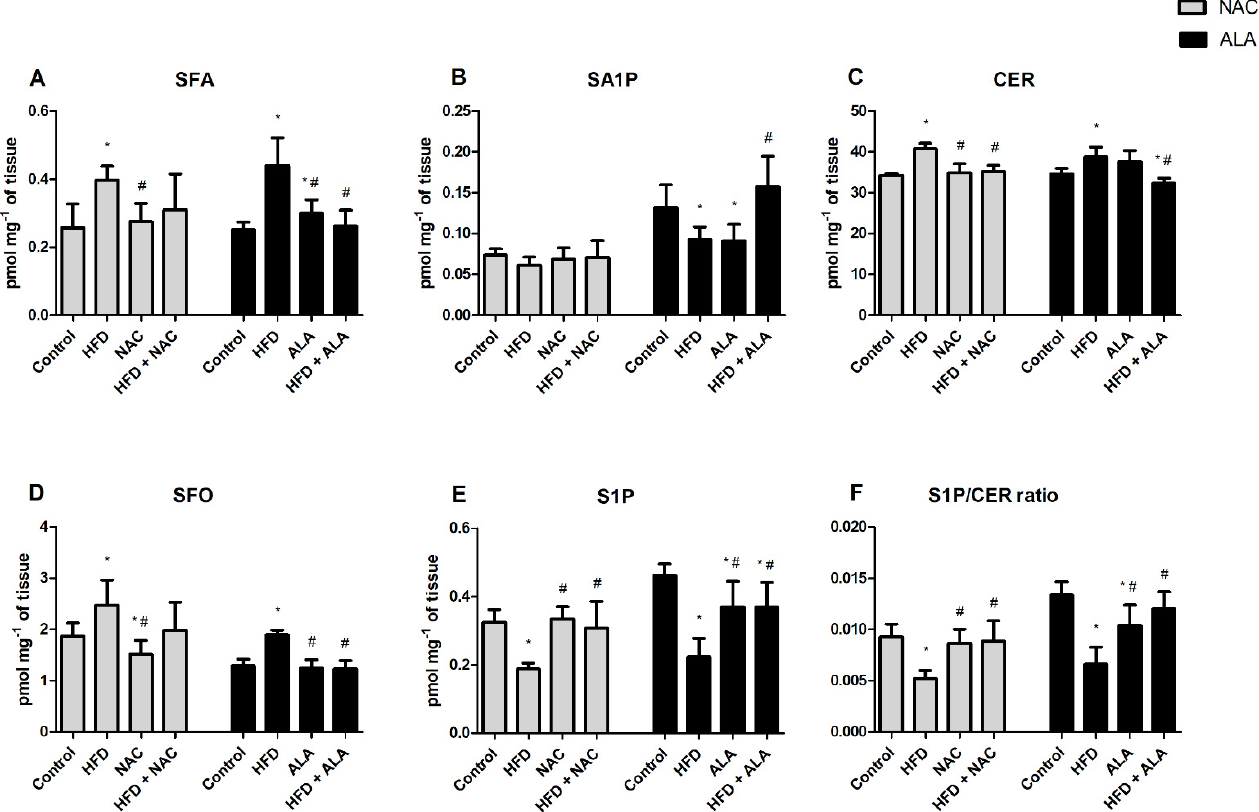
Figure 2. The content of sphingolipid pathway components, i.e., ( A ) sphinganine (SFA), ( B ) sphinganine-1-phosphate (SA1P), ( C ) ceramide (CER), ( D ) sphingosine (SFO), ( E ) sphingosine-1-phosphate (S1P), ( F ) sphingosine-1-phosphate/ceramide ratio (S1P/CER ratio) after eight-week treatment of n-acetylcysteine (NAC) or α -lipoic acid (ALA) in the left ventricle of rats fed a standard diet (Control group) or high-fat diet (HFD group). The data are expressed as the mean values ± SD and are based on ten independent determinations ( n = 10). * p < 0.05 significant difference vs. corresponding Control group; # p < 0.05 significant difference vs. corresponding high-fat diet group.